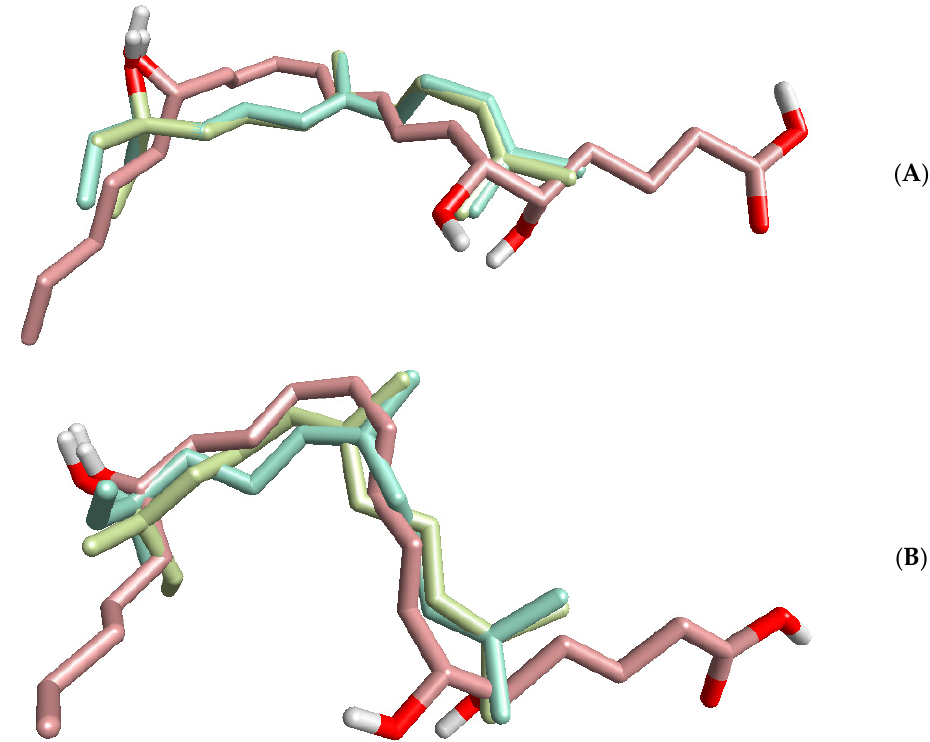
Figure 5. Alignments of lipoxin A 4 with E -nerolidol ( A ) and Z -nerolidol ( B ). Alignments were performed using FieldTemplater software. Lipoxin A 4 molecule is shown with a pink skeleton; the R and S enantiomers of nerolidol are shown with khaki and green skeletons, respectively.